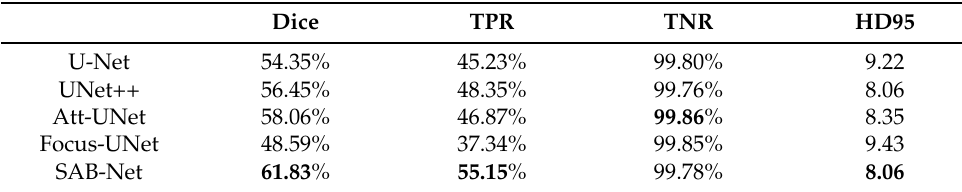
Table 2. Segmentation results obtained on the Brain MRI dataset.